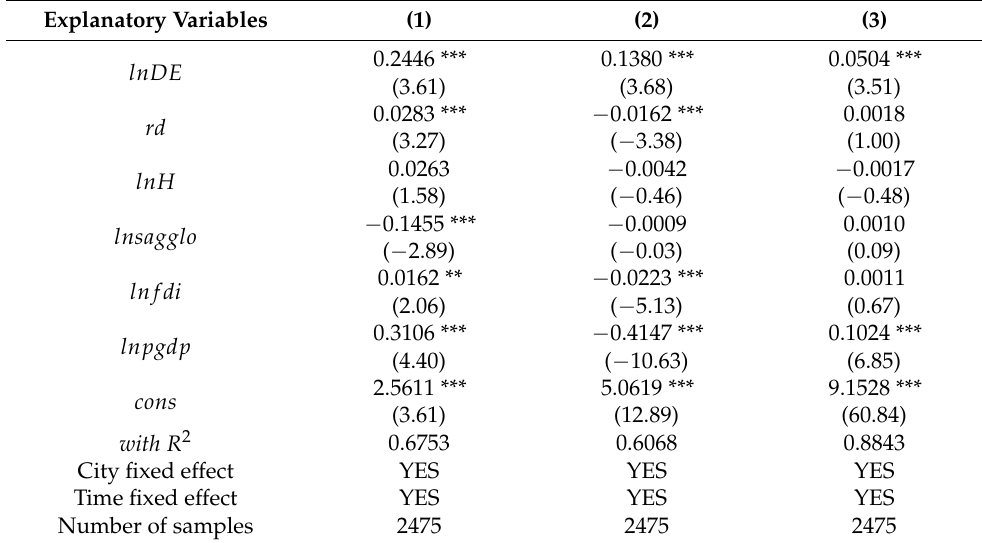
Table 6. Test results of the action